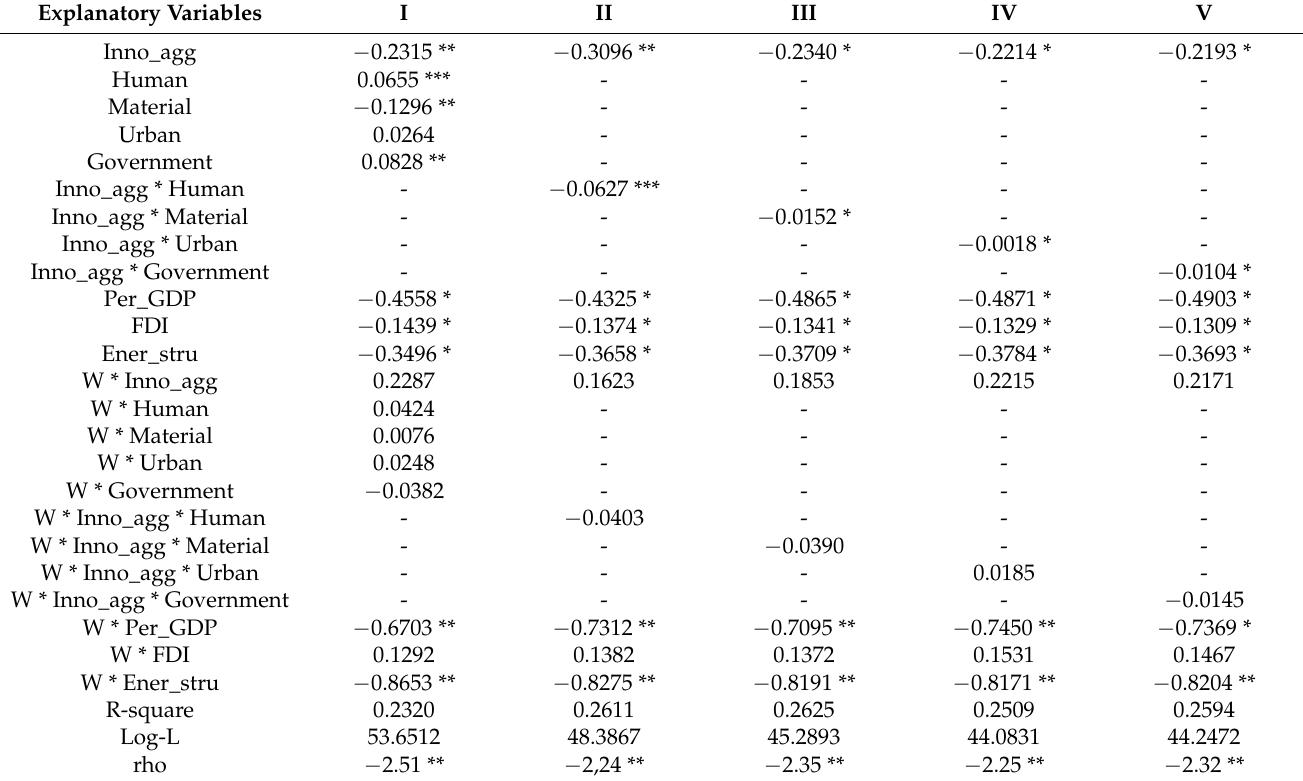
Table 2. Regression results.